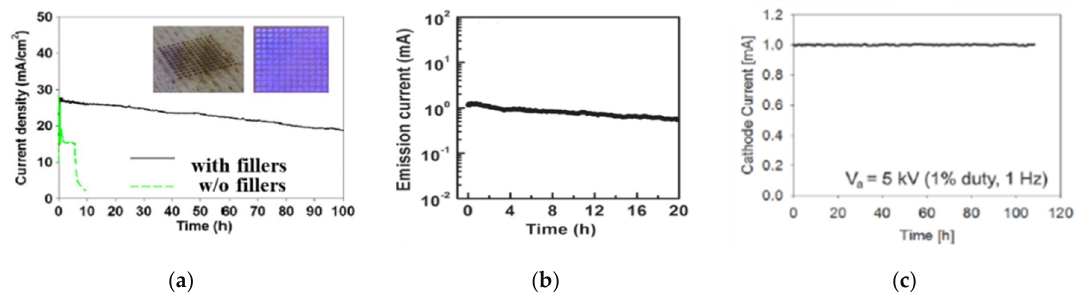
Figure 16. The lifetime tests, time vs. current, of the FE cathodes made of CNT pastes, with an addition of fillers. Figure 16a reprinted with permission from [142]. Figure 16b reprinted with permission from [115], and Figure 16c reprinted with permission from [141].